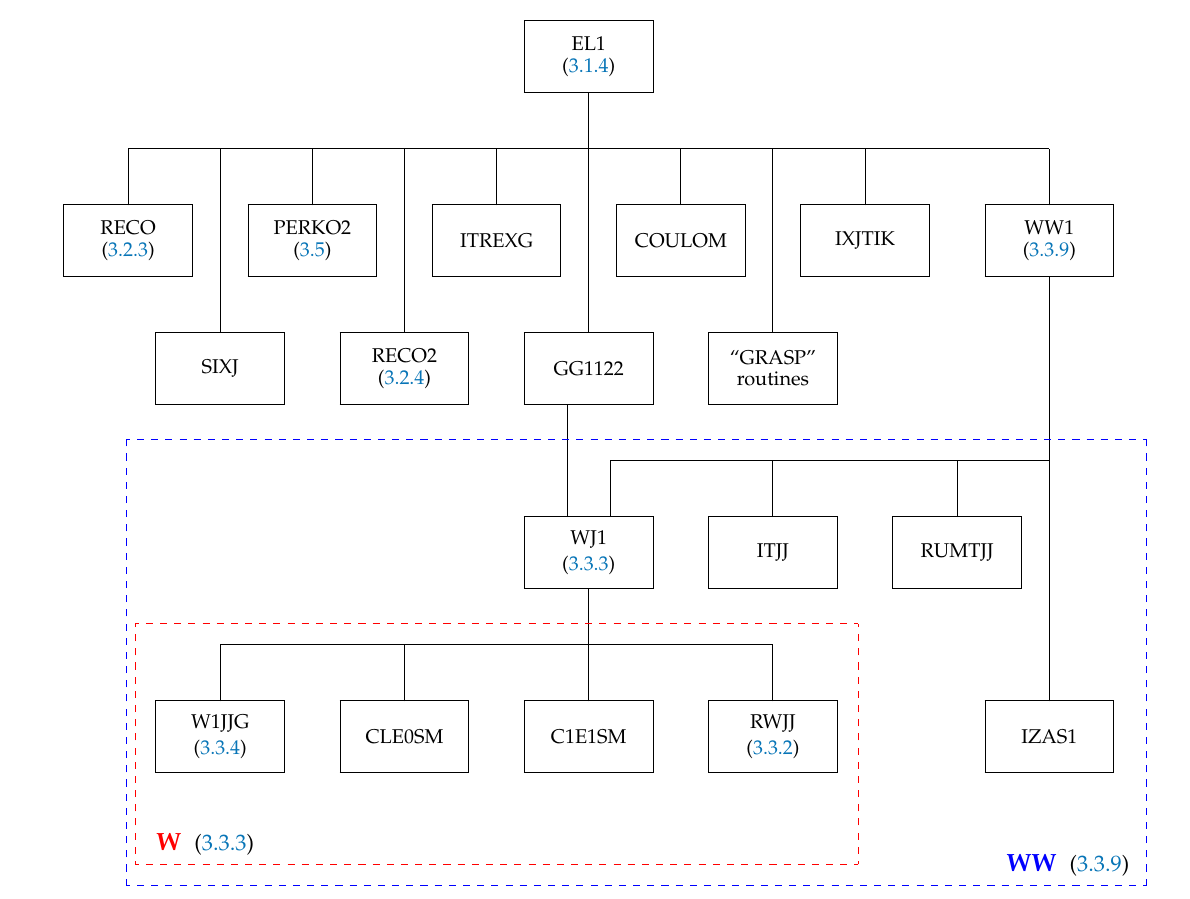
Figure 3. Structure of the subroutine EL1 . The box “GRASP” routines correspond to the routines ITRIG , SNRC , CXK , SPEAK , and TALK from the GRASP92 package [54]. The blue frame WW corresponds to the routine WW1 (computing the matrix element (94)) and shows its structure. Additionally, the red frame W shows the structure of the routine WJ (computing the matrix element